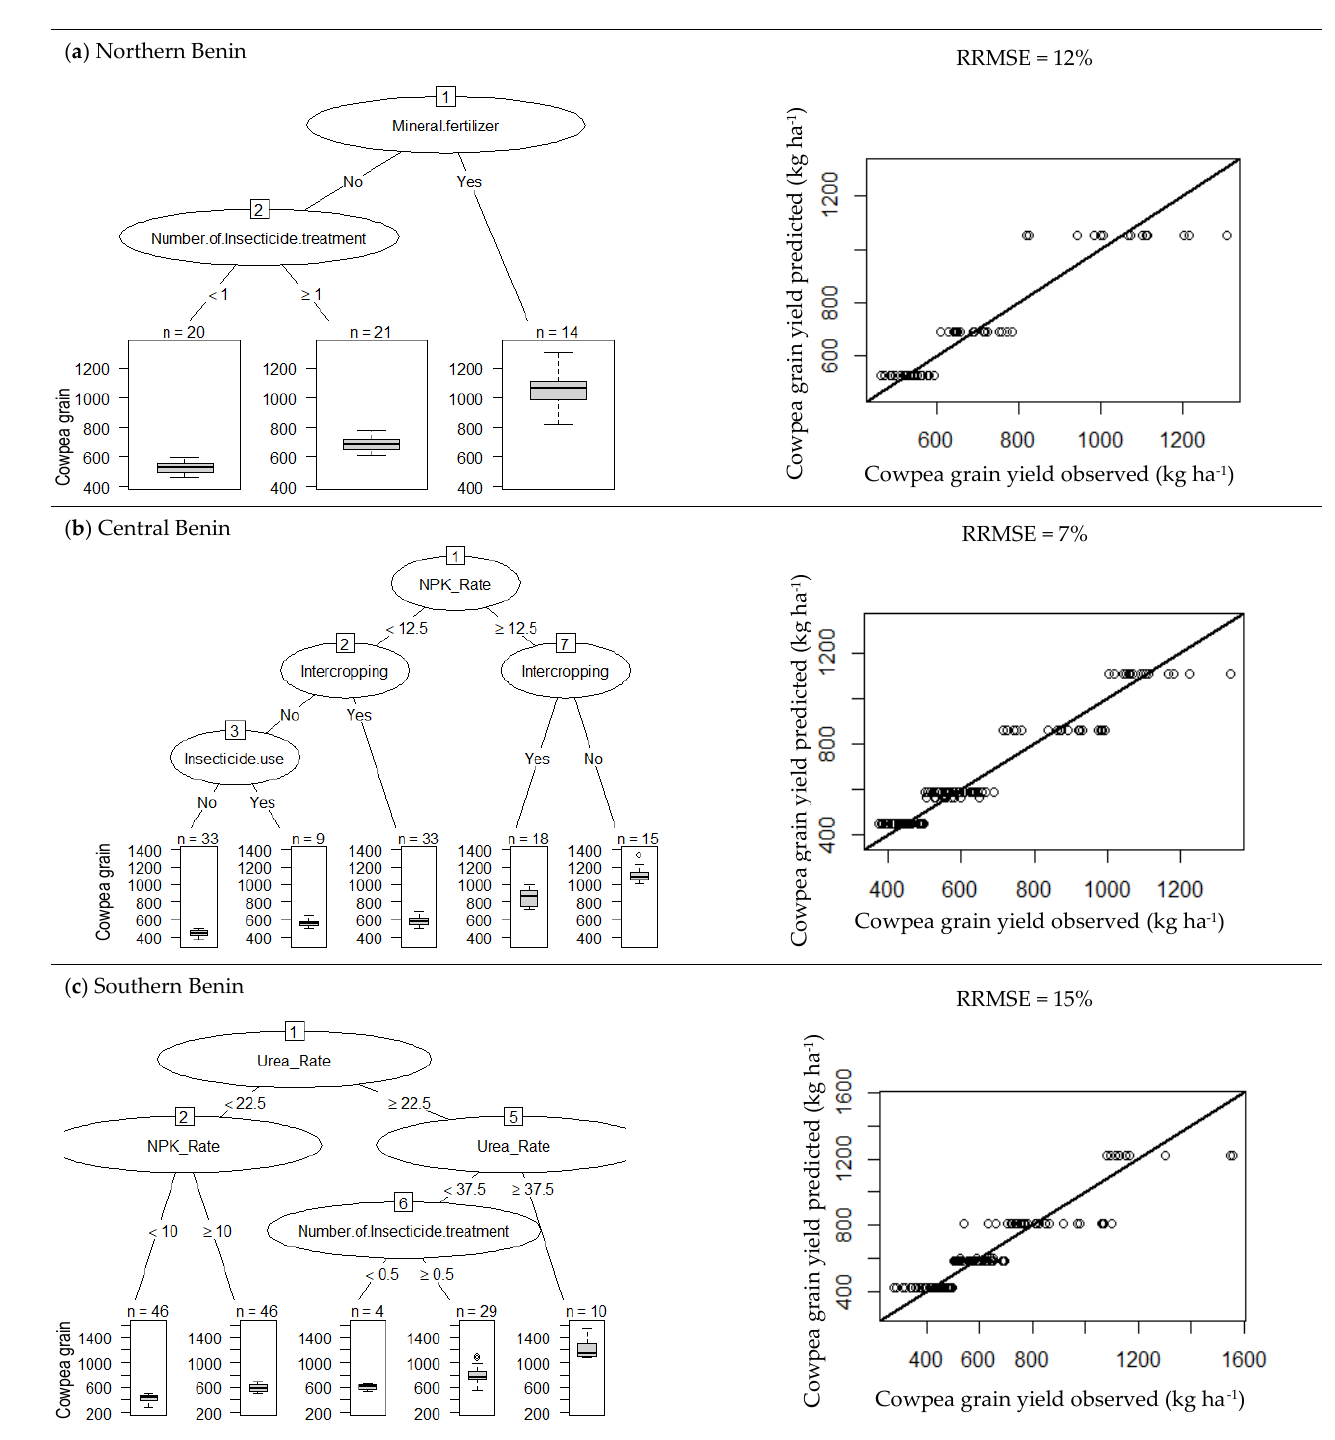
Figure 2. Model of regression tree of the agricultural practices driving cowpea grain yields from northern to southern Benin: ( a ) Northern Benin, ( b ) Central Benin, ( c ) Southern Benin. Urea rate (kg ha − 1 ), NPK rate (kg ha − 1 )